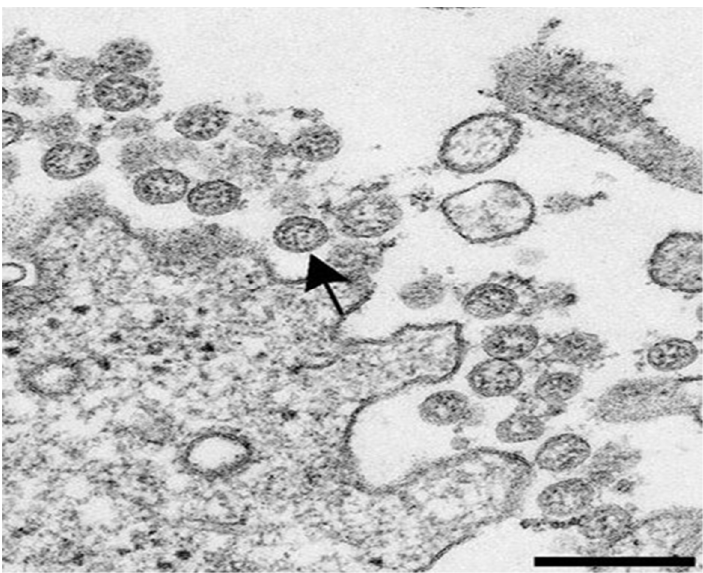
Figure 2. Transmission electron microscopy image of the SARS-CoV-2 isolated from patients showing extracellular spherical particles with cross-sections through the nucleocapsids (black dots). Arrow indicates a coronavirus virion budding from a cell. Scale bar indicates 200 nm. Published in [16] https: // dx.doi.org / 10.3201 / eid2606.200516.